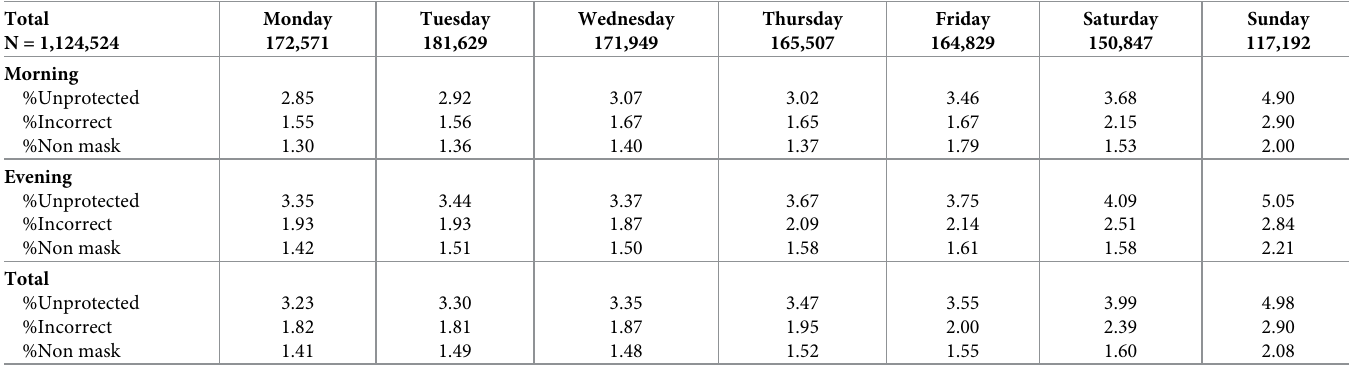
Table 4. The distribution of unprotected group according to date and time. Total N = 1,124,524